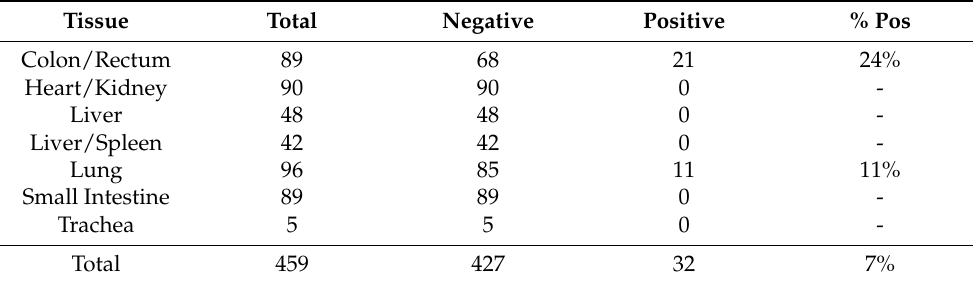
Table 2. Detailed tissue panel tested for SARS-CoV-2. The distribution of SARS-CoV-2 RNA detection in the first 96 animals is listed. Tissue, tissue or tissue pools received; Total, total number tested in each category; Negative, number of N1 RT-PCR negatives; Positives, number of N1 RT-PCR positives; % Pos, percentage of tissues positive for coronavirus.